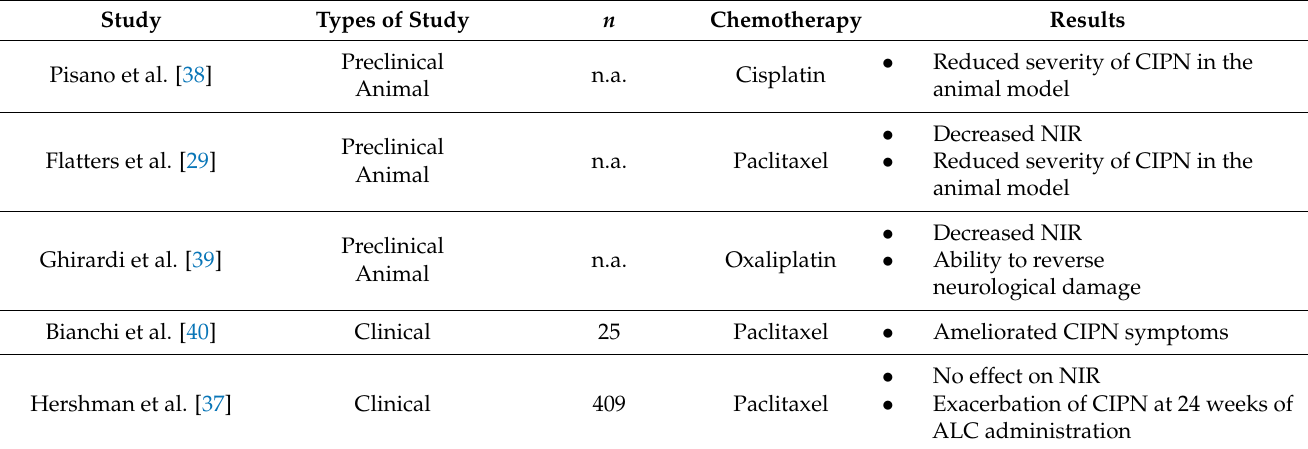
Table 1. Efficacy of ALC in